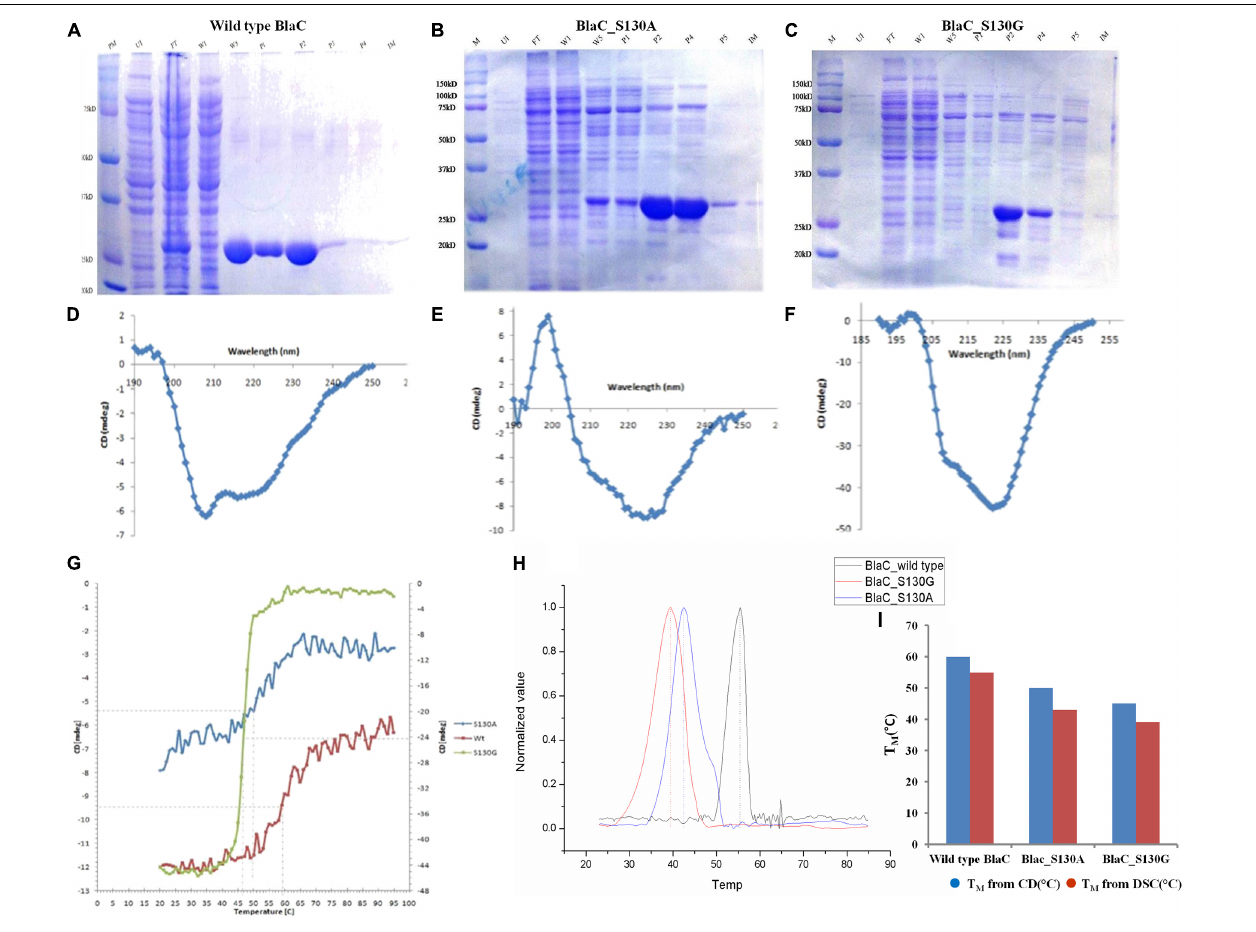
FIGURE 2 | Production and biophysical characterization of wild-type and variant BlaC. (A) Production of wild-type BlaC. (B) Production of S130A BlaC. (C) Production of S130G BlaC. (D) CD spectra of wild-type BlaC. (E) CD spectra of S130A BlaC. (F) CD spectra of S130G BlaC. (G) Thermal denaturation comparison of wild-type and variant BlaC by CD spectroscopy. (H) Determination of melting temperature using DSC. (I) Comparison of melting temperature of wild-type BlaC and its variant coming from CD spectroscopy and DSC. CD, circular dichroism; DSC, differential scanning calorimetry.